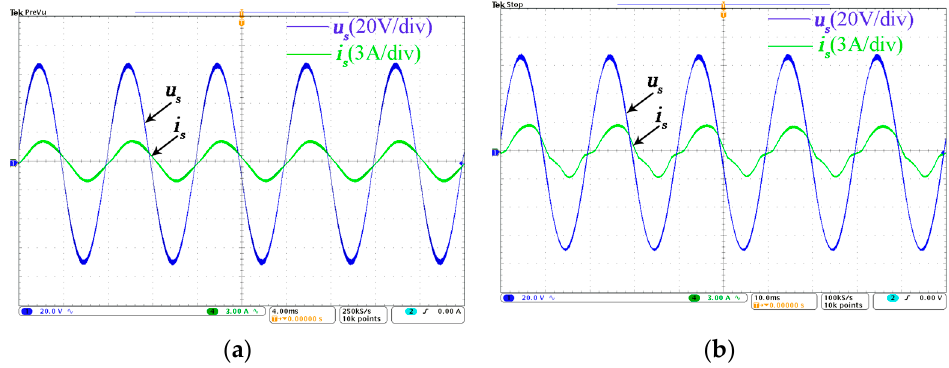
Figure 8. Waveforms of input voltage and current of the hybrid cascaded rectifier operation mode under lagging power factor. ( a ) Within the adjustable power factor angle range; ( b ) beyond the adjustable power factor angle range.